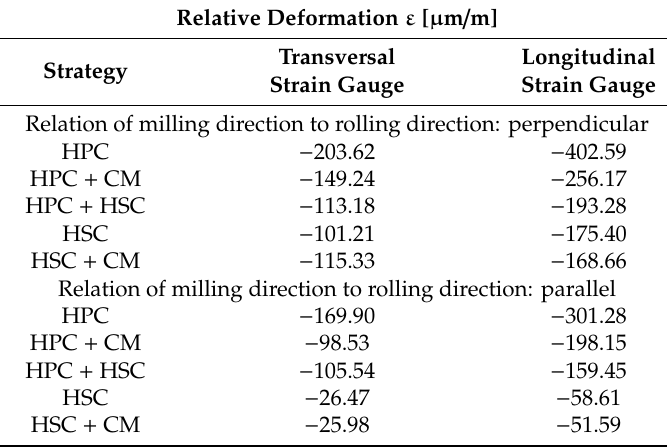
Table 5. Relative deformation ε obtained for samples in which the textured surface layer was not removed, the analysed cutting strategies and the tested relations between the milling direction and the rolling direction.